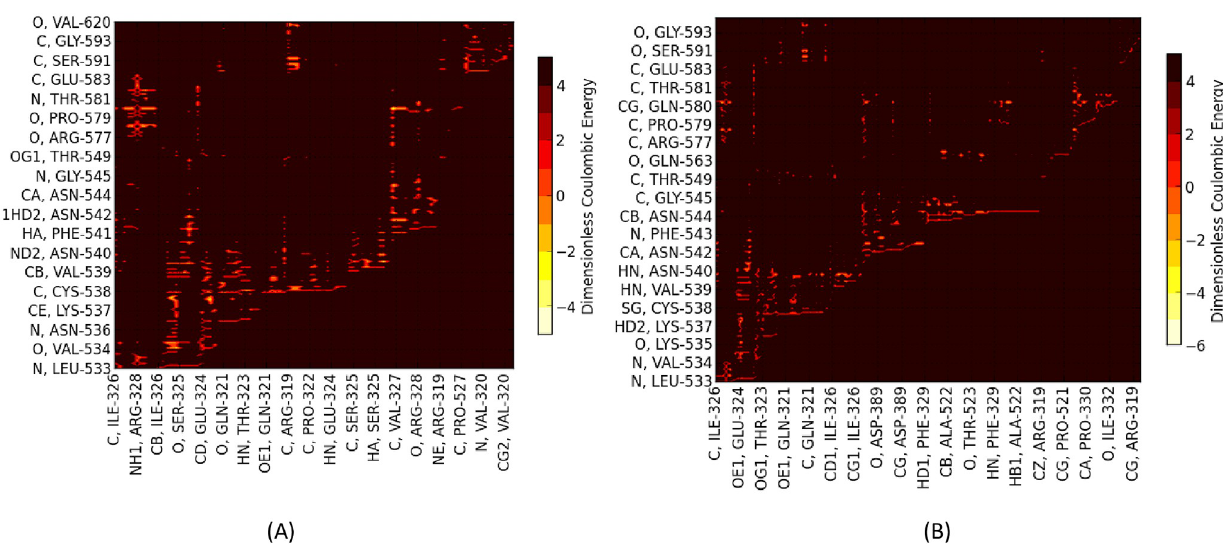
Fig 5. (A) Dominant Energy Landscape for Partial Charge Interactions between SD1/SD2 residues of Chain A (Up) (vertical axis) and RBD of Chain A (Up) (horizontal axis) (PDB ID: 6VSB). (B) Dominant Energy Landscape for Partial Charge Interactions between SD1/SD2 and RBD of Chain B (Down)